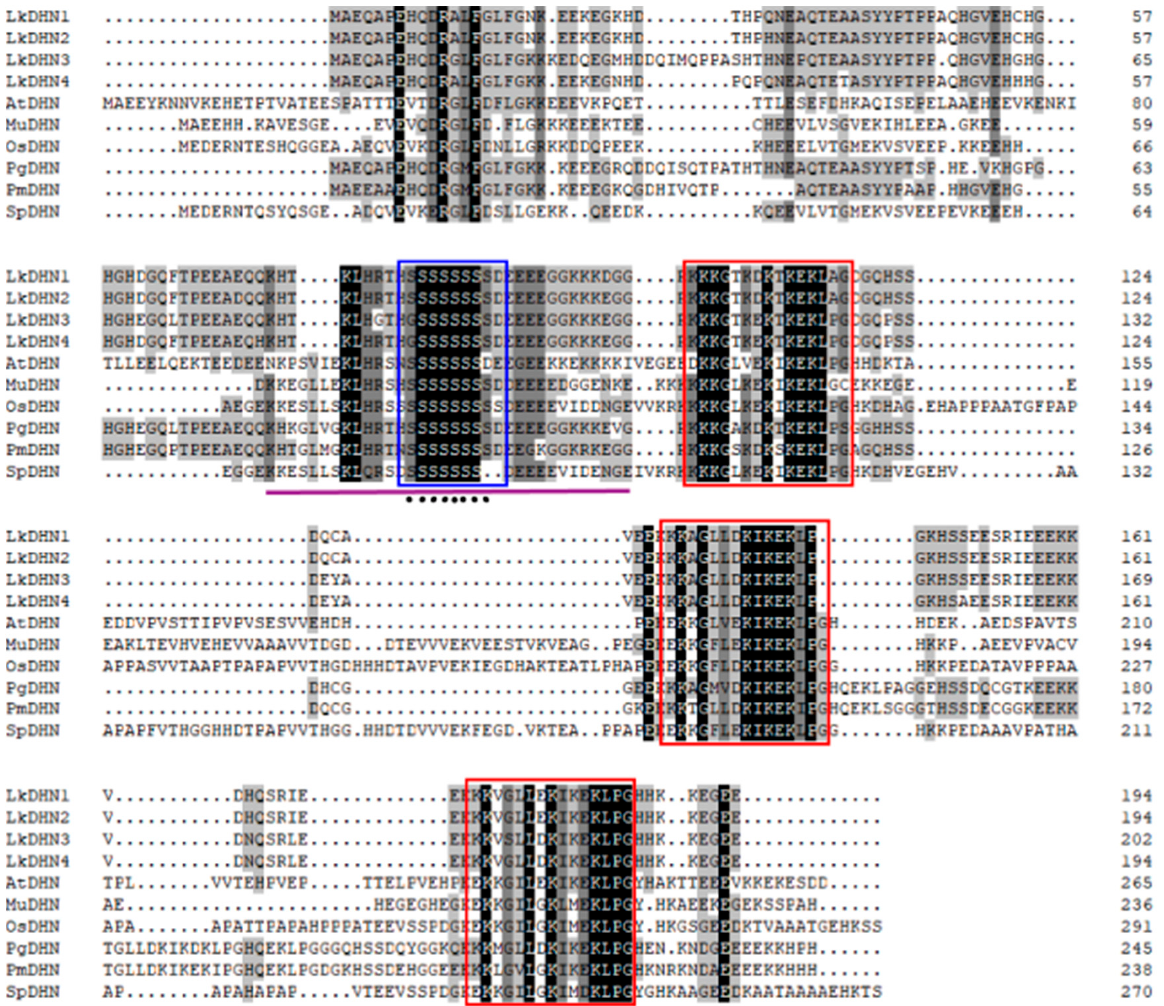
Figure 1. Alignment of LkDHNs (Dehydrin in Larix kaempferi ) and DHNs from other plants. Six verified DHNs including AtDHN ( Arabidopsis thaliana ), MnDHN ( Musa nana ), OsDHN ( Oryza sativa ), PgDHN ( Picea glauca ), PmDHN ( Pinus massonia ), SpDHN ( Stipa purpurea ) and LkDHNs homologous sequence were aligned by DNAman 8.0. The S segment was indicated by blue box; K segments were indicated by red boxes; nuclear localization signals (NLS) were indicated by the purple line; phosphorylation sites were indicated by black dot.